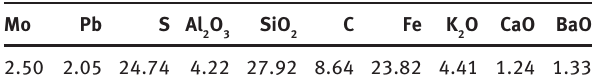
Figure 1: The flow chart of molybdenum recovery from alkali leach- ing solution of low-grade molybdenum concentrate. Table 1: Main compositions of the low-grade molybdenum concen- trate